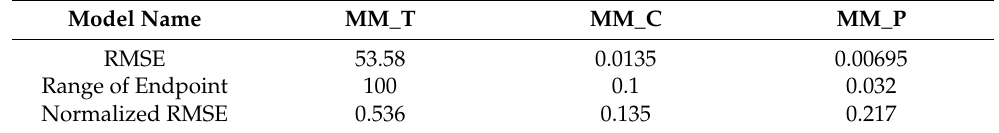
Table 6. Model evaluations of the theoretical models for endpoint temperature, carbon, and